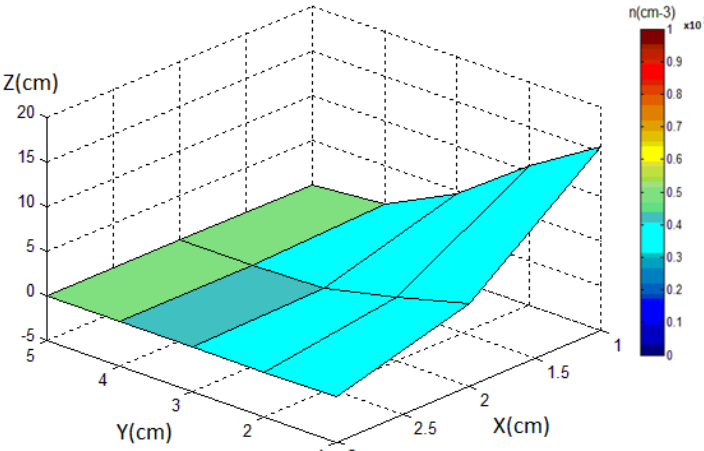
Figure 3: The spatial profile of electron number density of carbon laser induced plasma at z=1cm.